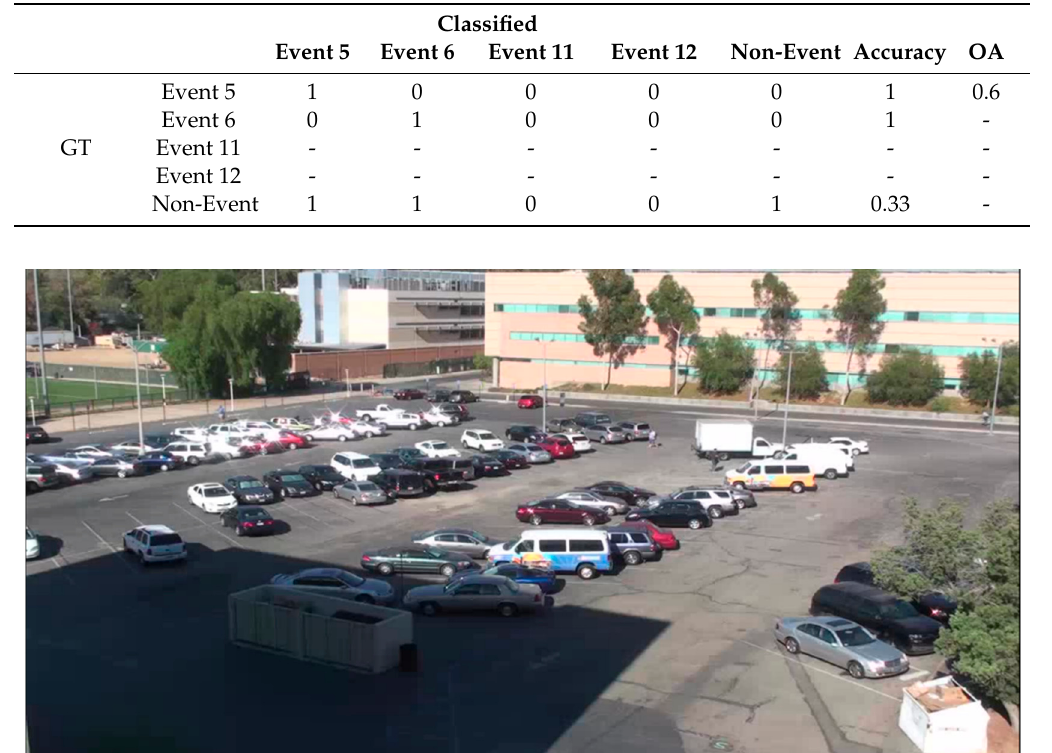
Figure 6. VIRAT_S_010111_08_000920_000954 Scene. This parking lot scene is quite challenging due to